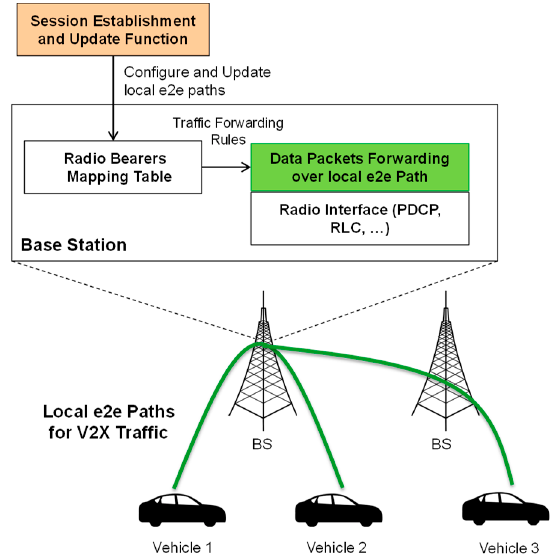
Figure 9. Overview of vehicle-to-vehicle (V2V) paths via the cellular interface.